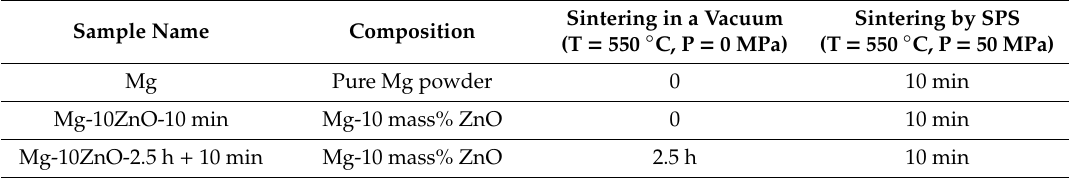
Table 1. Name, composition, and synthesis conditions of the samples.